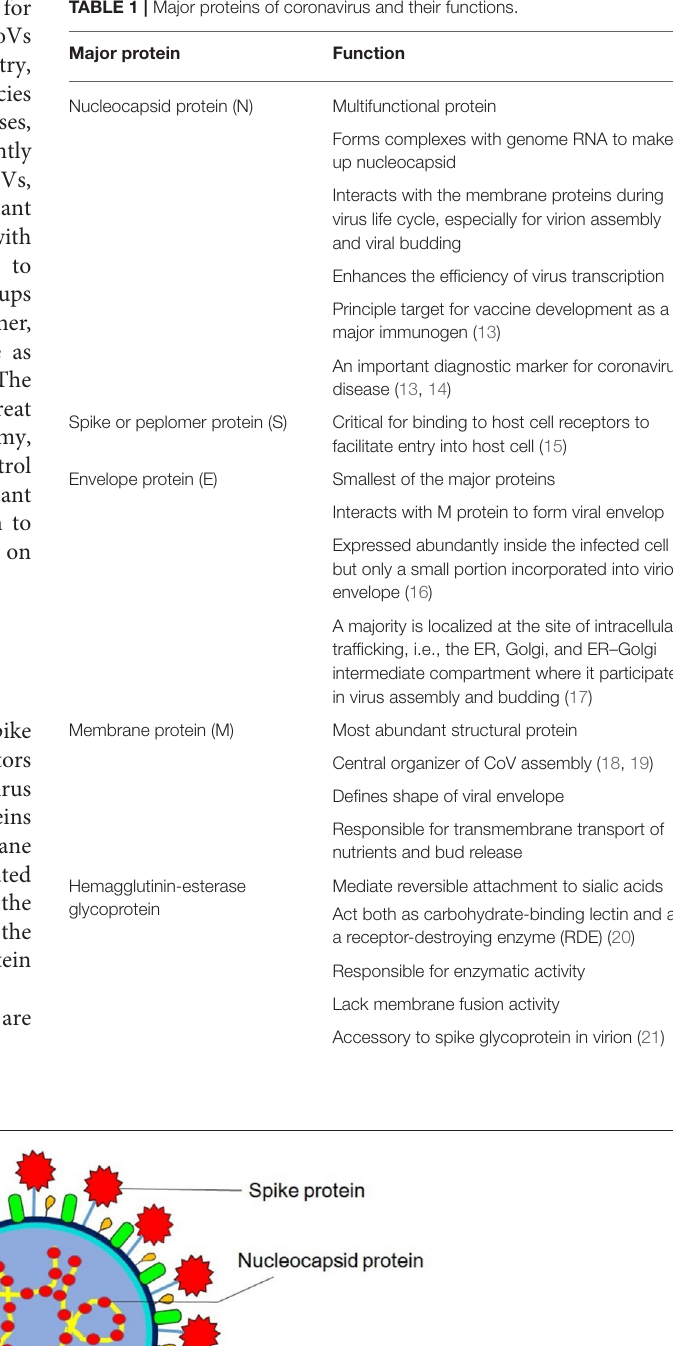
TABLE 1 | Major proteins of coronavirus and their